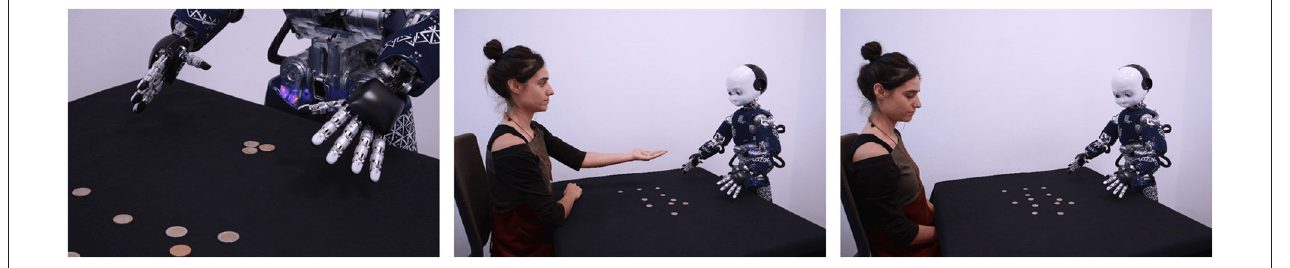
FIGURE 1 | Example scenario from the questionnaire of Marchesi et al.